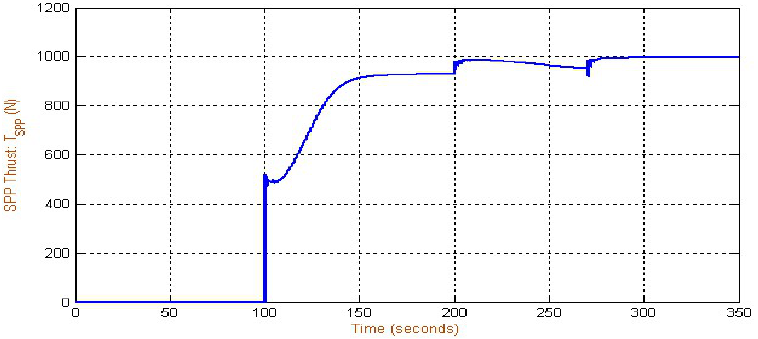
Figure 25. Equilibrium trim versus time.